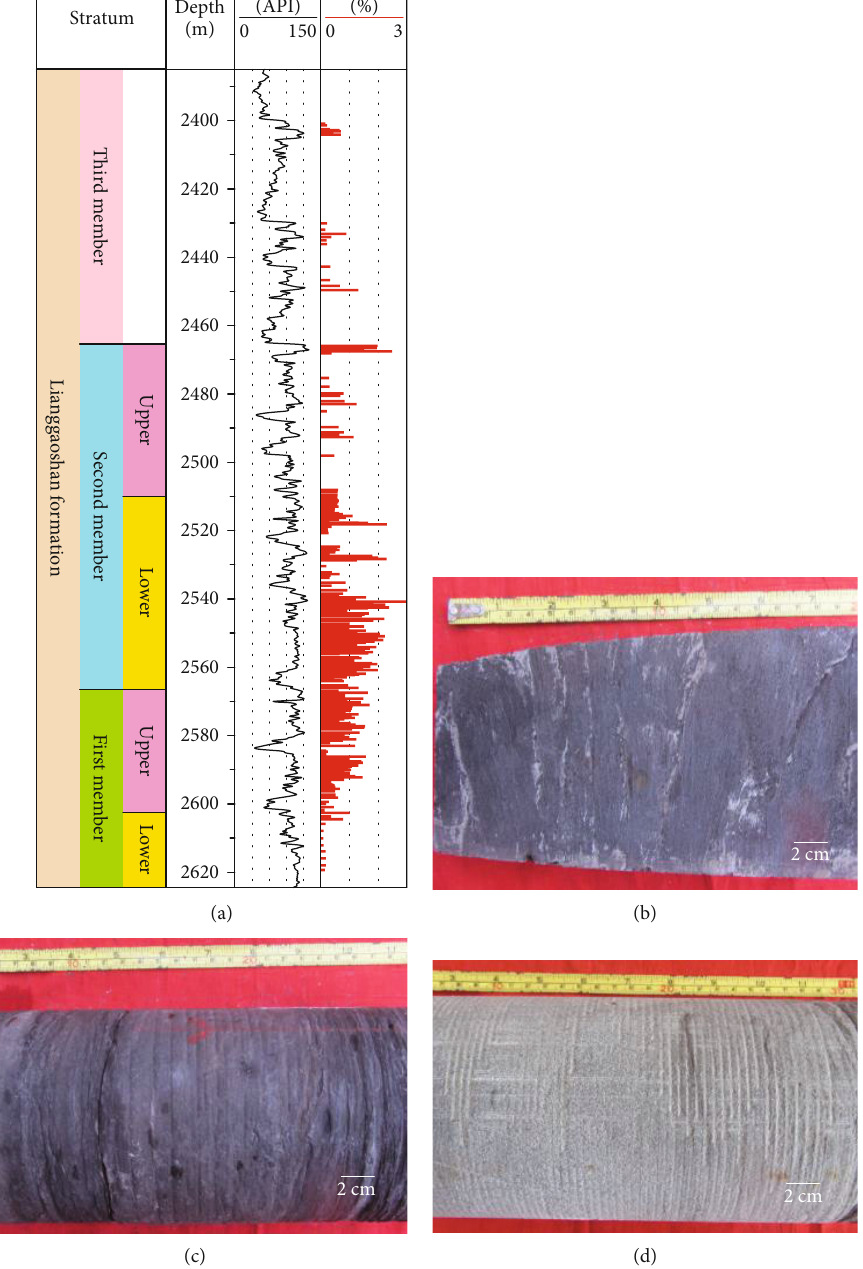
Figure 2: Column diagram and core photos of the Middle Jurassic Ranggosan Formation stratigraphy in well TY1. (a) Stratigraphic column diagram of the TY1 well; (b) dark gray shale of the upper subsection of the fi rst section of the Ryanggosan Formation in TY1 well, 2579 m; (c) gray-black shale of the lower subsection of the second section of the Ryanggosan Formation in TY1 well, 2542m; (d) gray fi ne sandstone of the third section of the Ryanggosan Formation in TY1 well, 2421m. See Figure 1 for the well